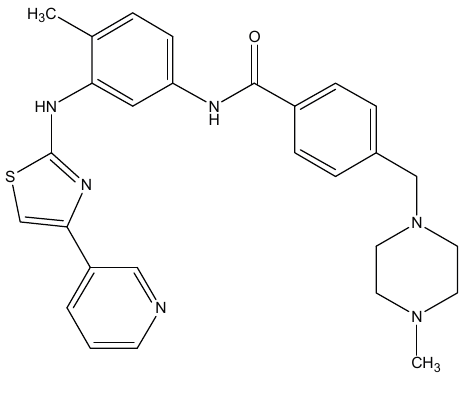
Figure 17. Structure of masitinib.